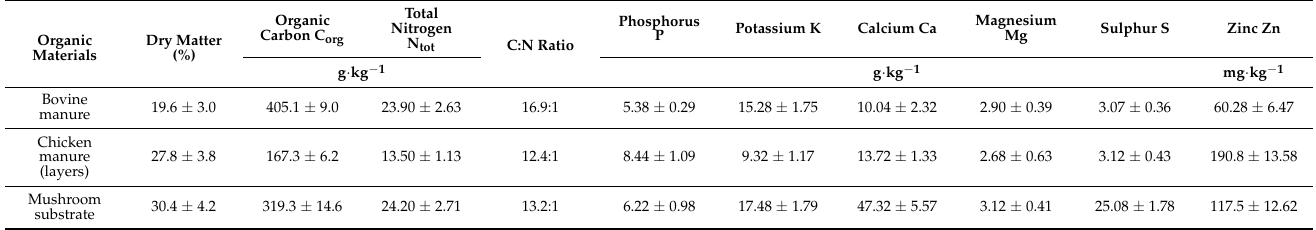
Table 1. Selected properties of organic fertilizers (mean ± SD, given on the dry matter,